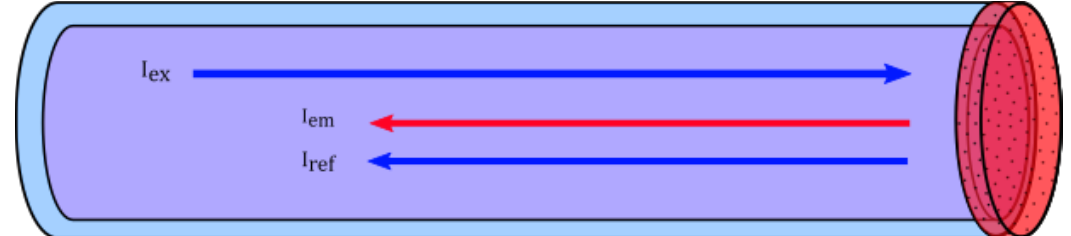
Figure 1. Concept for the fiber-optical sensor. The end-surface of the fiber is coated with a thin layer of polymer containing the oxygen-sensitive platinum-octaethylporphyrin (PtOEP). Excitation light will travel through the fiber and interact with the sensing matrix. Photoluminescence emission and reflected excitation light will return through the fiber, and can be separated by suitable